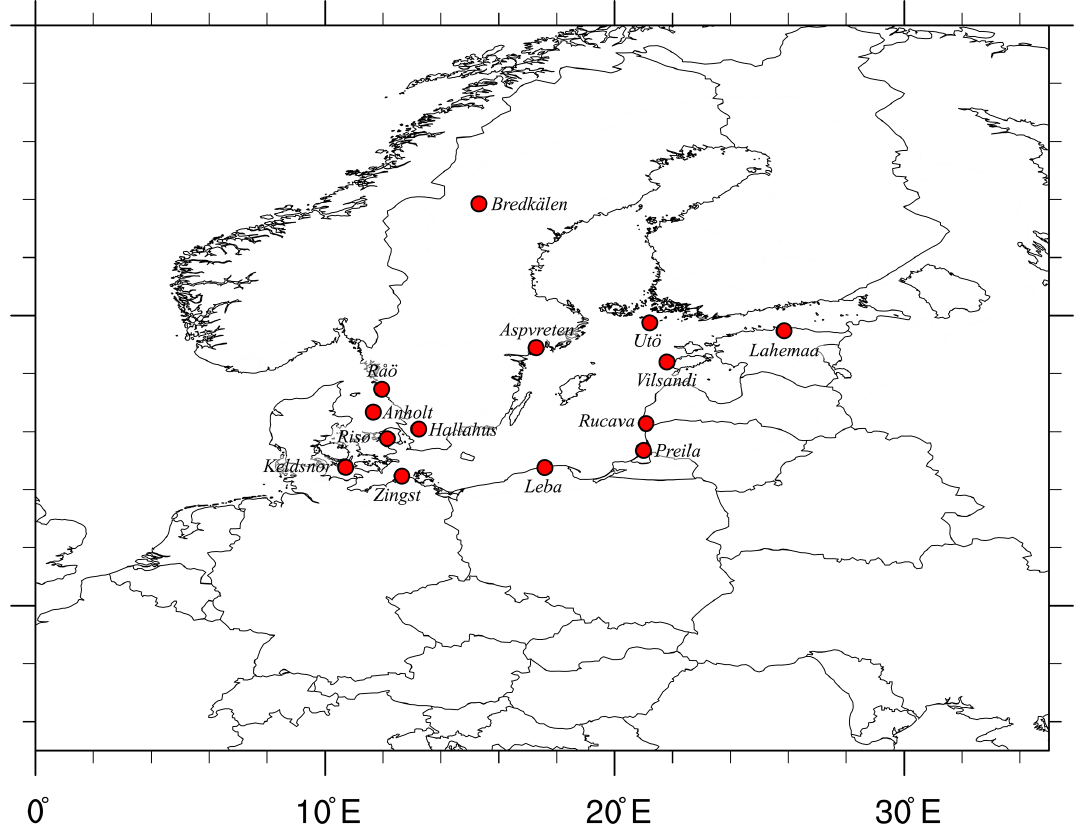
Figure A1. Location of the measurement sites shown in Figs. A2 to A4 and listed in Tables 2 and 3.